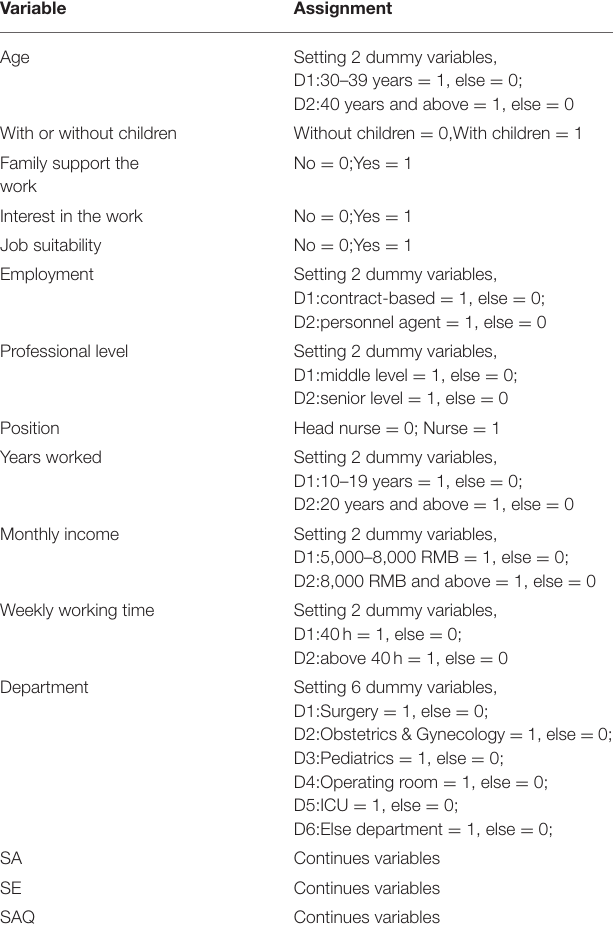
TABLE 3 | The assignment of independent variables. Variable